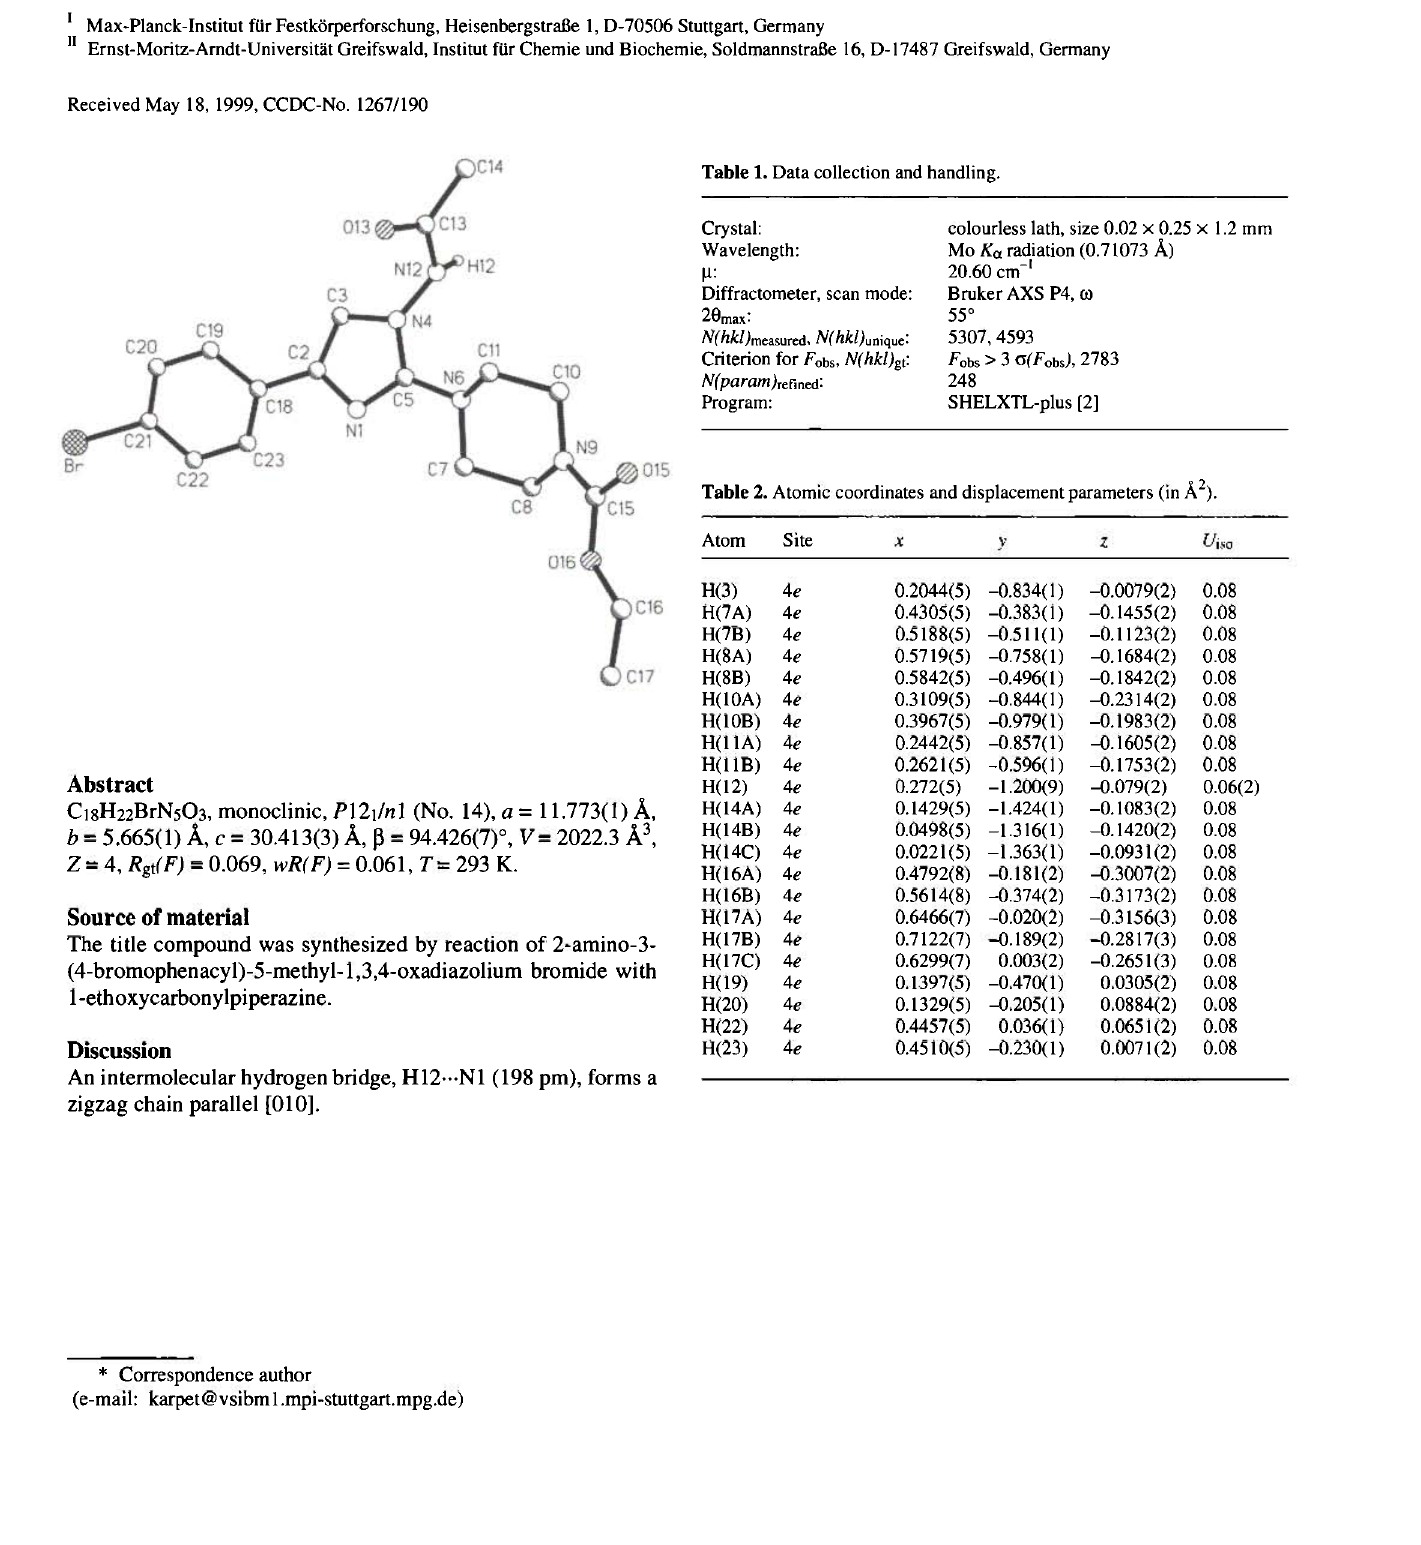
Table 1. Data collection and handling.